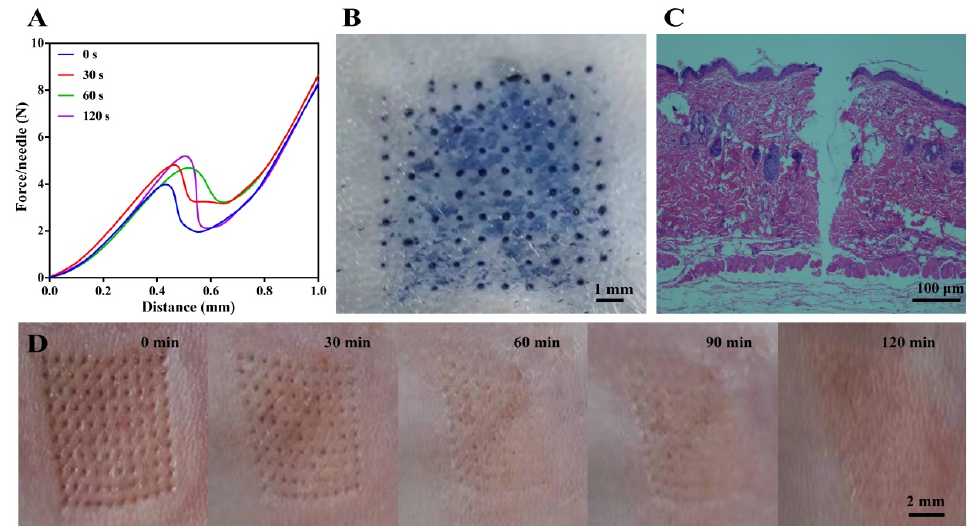
Figure 3. Mechanical property of the separable MN. ( A ) Average mechanical strength of single microneedle. ( B ) Mouse skin insertion with trypan blue staining. ( C ) H & E staining of mouse skin after MN application. ( D ) Time ‐ dependent skin recovery after MN insertion.